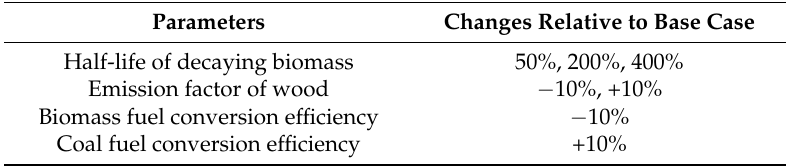
Table 3. Parameters and parameter values included in the sensitivity